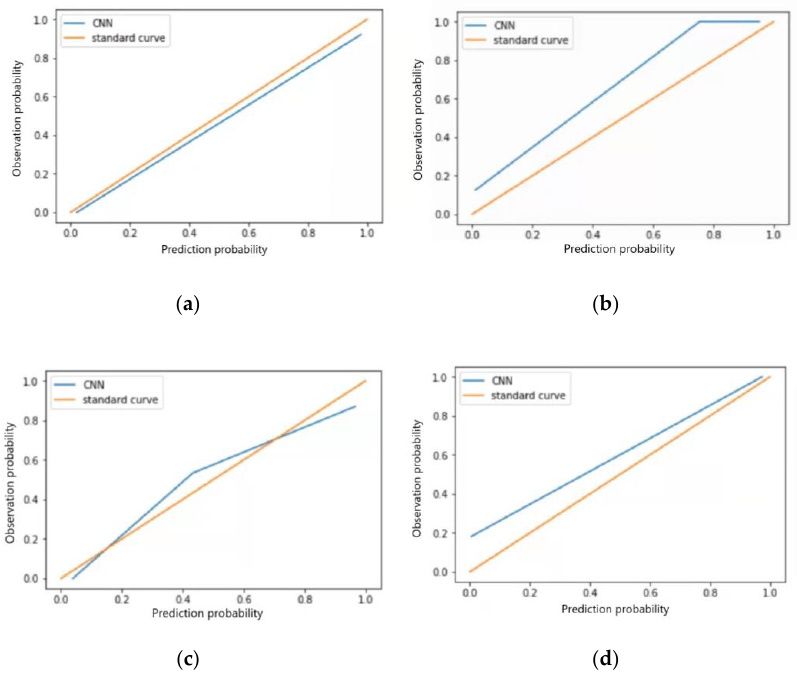
Figure 7. Calibration curves for four typical anomaly categories of test sets: ( a ) Sinus bradycardia; ( b ) Sinus tachycardia; ( c ) Myocardial ischemia; ( d ) Nonspecific intraventricular conduction delay.